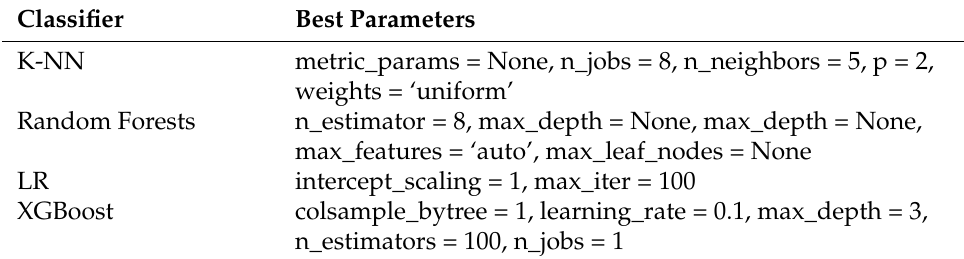
Figure 10. Accuracy comparison for the top features selected by F-test. Table 5. Parameters Tuning Using Scikit-learn